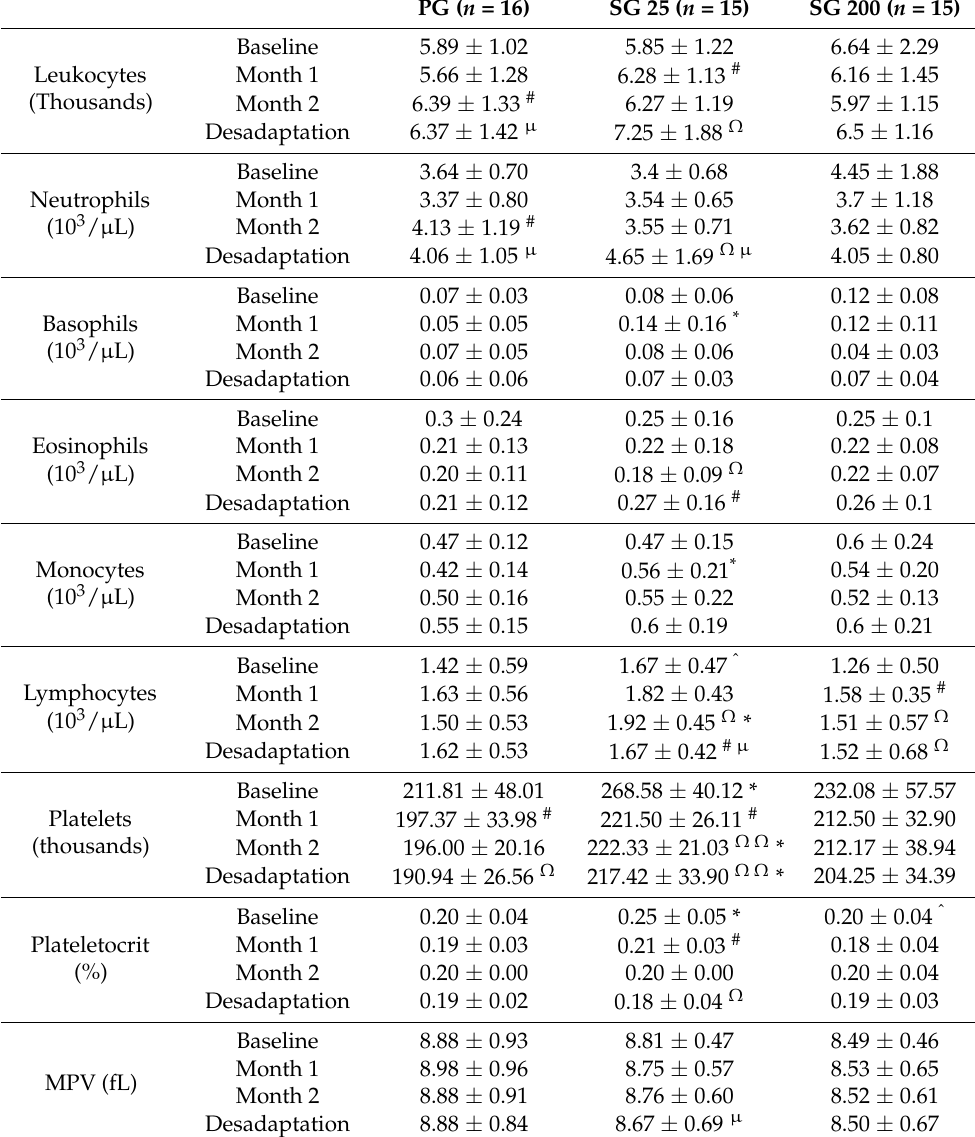
Table 5. White blood cell and platelet counts at the evaluations.